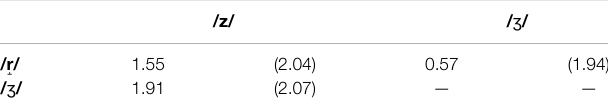
TABLE 3 | Mean d-prime values for each comparison in the Czech experimental block (SD in